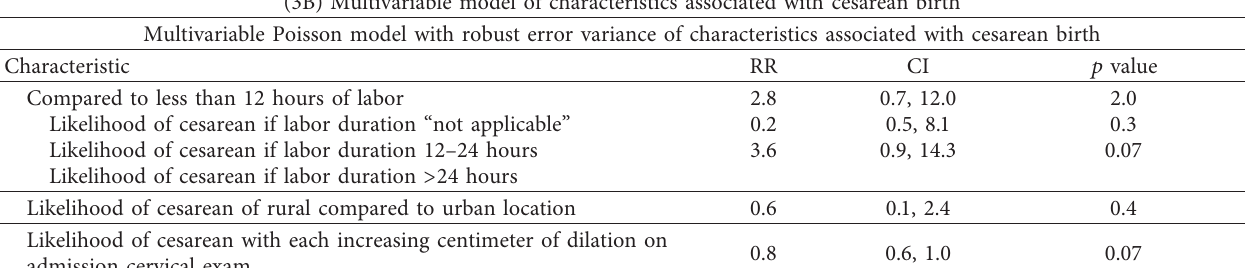
(3B) Multivariable model of characteristics associated with cesarean birth Multivariable Poisson model with robust error variance of characteristics associated with cesarean birth